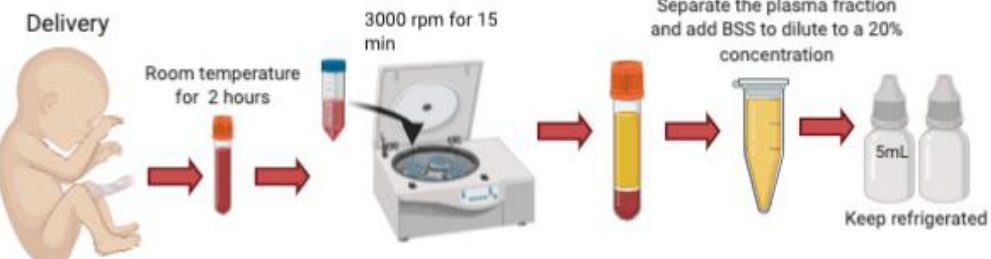
Figure 1. Preparation of umbilical cord serum tears. UCB is collected from the umbilical vein following delivery. It is kept at room temperature without anticoagulants for 2 h to induce clotting. It is centrifugated and the serum separated under sterile conditions. The serum is diluted with sterile saline to a 20% concentration, and aliquoted into sterile 5 mL droppers.